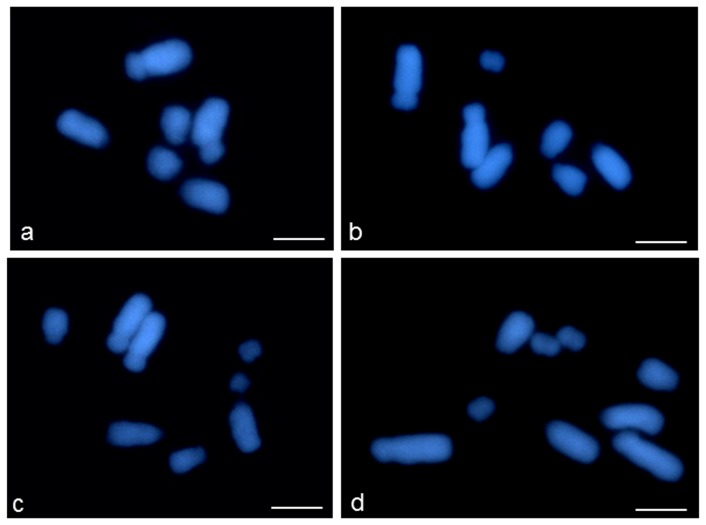
Full metaphase chromosome complements of Crepis capillaris with a different number of B chromosomes (DAPI staining).a) 2n = 6+0B; b) 2n = 6+1B; c) 2n = 6+2B; d) 2n = 6+3B. Bars represent 5 µm.